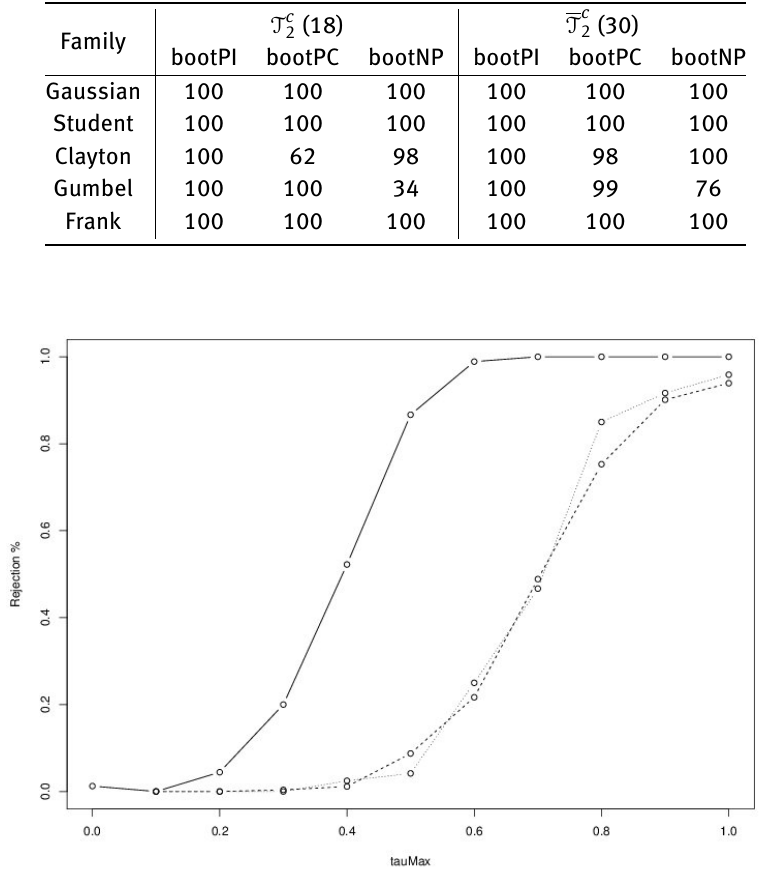
Table 4: Rejection percentages under the alternative (parametric tests).